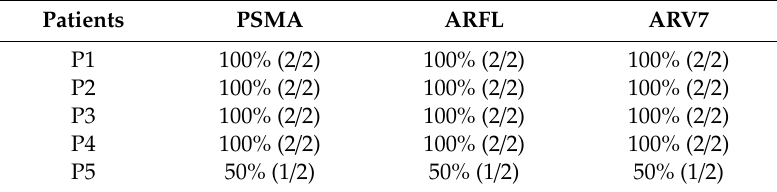
Table 4. Adna ARV7 Test concordance between two independent blood samples from five patients. Numbers in brackets refer to the replicates (number of samples with concordant results / total number of